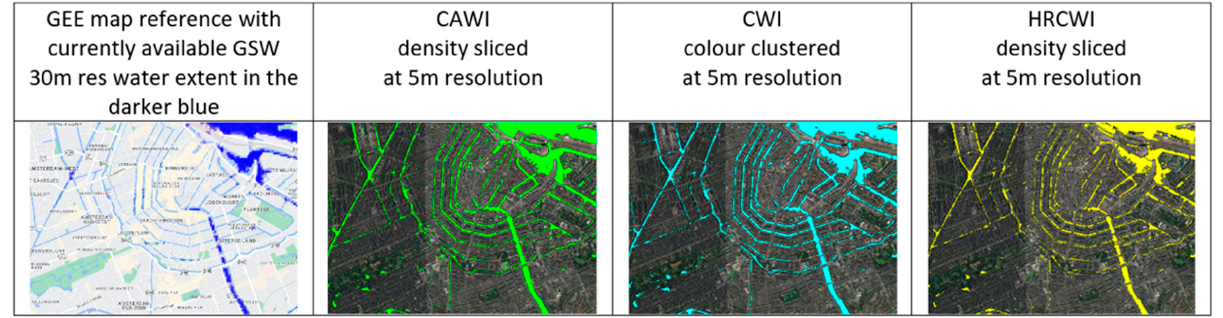
Figure 9. Comparison of best performing water indices in a complex urban area (Amsterdam) on a VHR image background in GEE. CAWI ≥ 1.157, HRCWI ≥ 0.22.